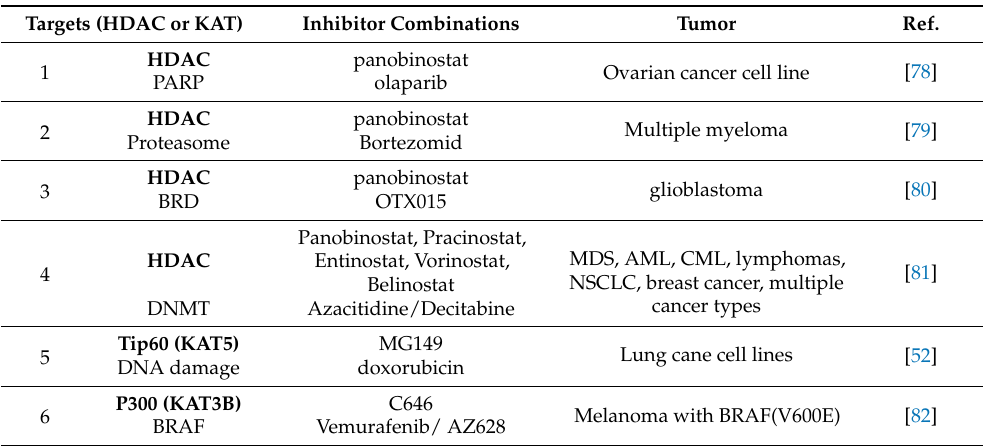
Table 2. Candidate combinations for synthetic lethality strategies targeting chromatin deacetylases (HDAC) and acetylases